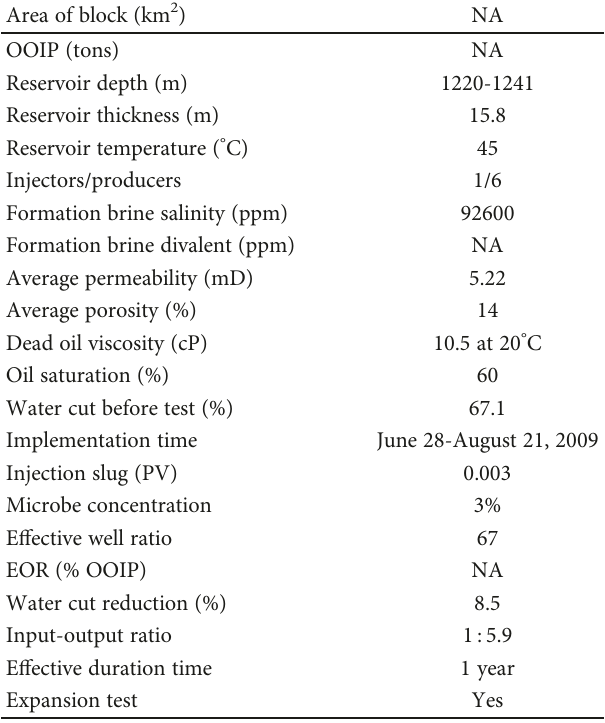
Table 8: Ansai MFR pilot in Changqing Oil fi eld [31, 67,